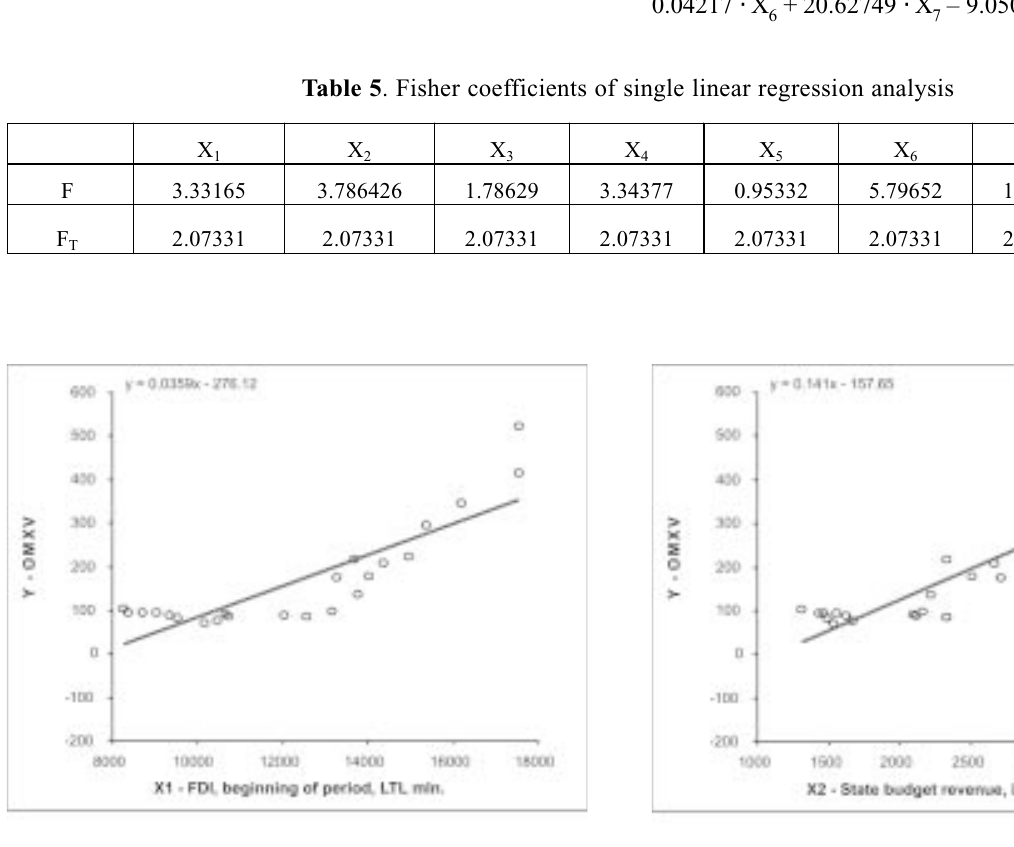
Fig 2. Dependence of OMXV index on state budget revenue (mill. Lt)